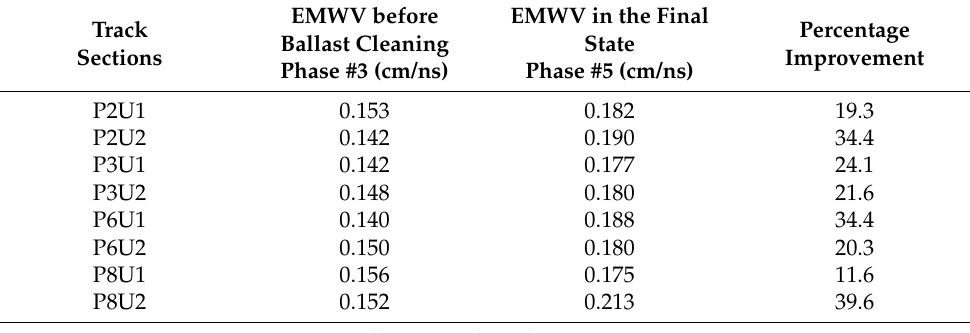
Table 6. Percentual increase in Electromagnetic Wave Velocity (EMWV) values during the mainte- nance works between phase 3 and phase 5.